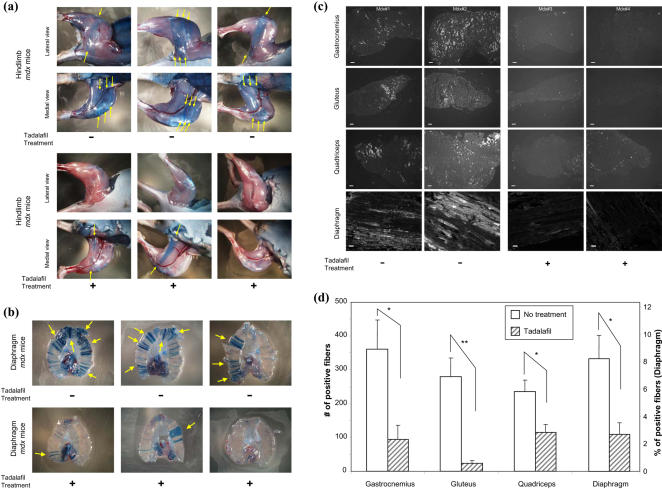
Evans Blue staining of the damaged fibers in the hindlimb and the diaphragm muscles of mdx mice (4 weeks old).(a&b) Six hours after the injection of Evans Blue dye, the extent of myofiber damage as indicated by blue staining was observed in the superficial hindlimb muscles (a) and the diaphragm (b). Three mice from each group are shown (a and b). Compare lateral and medial views of the stained fibers (arrows) in mice without (−) and with (+) tadalafil treatment (a). Mice without tadalafil treatment (−) show extensive blue staining (arrows in a and b). Tadalafil treatment (+) ameliorated the damage in the same muscle tissues, although it did not completely suppress the myofiber damage in some mdx mice. (c) Gastrocnemius, gluteus maximus, quadriceps, and diaphragm muscles were harvested and cryosectioned for fluorescence microscopic observation. In the non-treated group (Mdx#1 and #2 in c), all the muscles studied showed increased numbers of damaged myofibers stained by the injected dye (high fluorescence signals are shown in white). Tadalafil treatment reduced the numbers of damaged myofibers (Mdx#3 and #4 in c). The white scale bar at the bottom of images represents 100 µm for gastrocnemius, gluteus, and quadriceps, and 50 µm for diaphragm. (d) The number of positively stained damaged myofibers (in c) were counted and shown as bar graphs for the entire gastrocnemius, gluteus, and quadriceps muscles. For diaphragm muscles, the positively stained myofibers are shown as percentage of the total fiber count. Mdx mice without treatment (N = 10, white columns) showed extensive amount of myofiber damage. Tadalafil treatment (N = 8, columns shaded with hatched lines) showed a statistically significant decrease in the amount of damaged myofibers in gastrocnemius, gluteus maximus, and quadriceps muscles. *: p<0.05, **<p<0.01 by t-test. N refers to the number of animals used for each treatment.